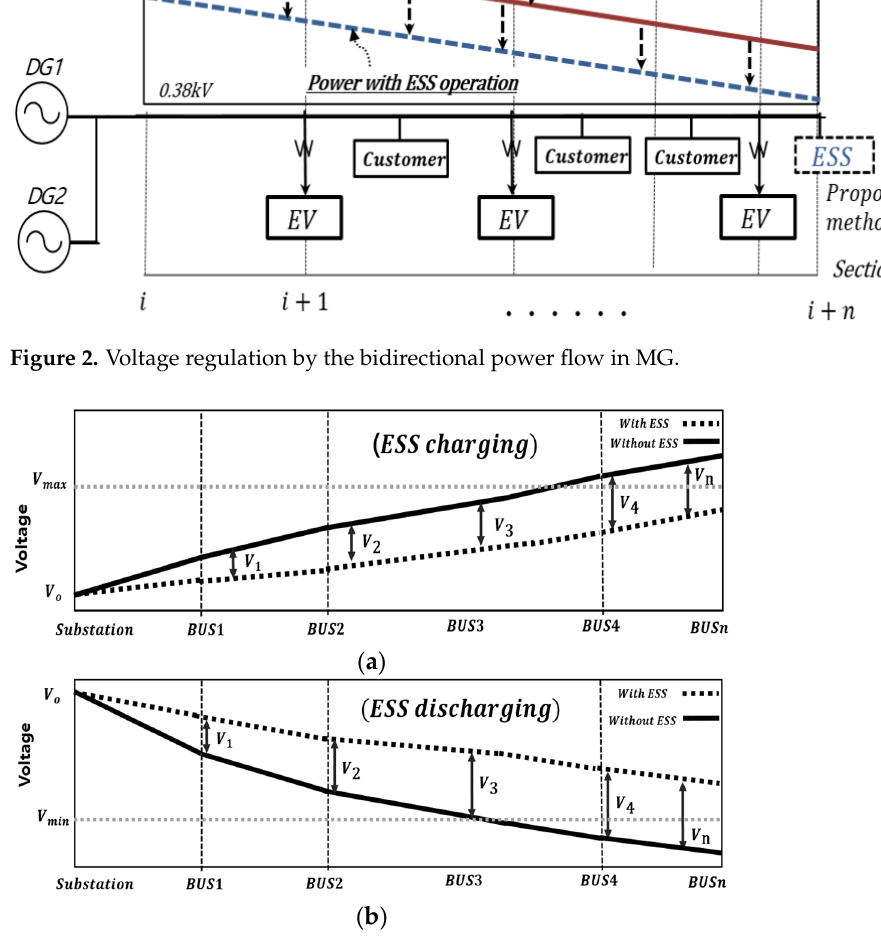
Figure 3. Bus voltage according to ESS charging/discharging. ( a ) Bus voltage characteristics during ESS charging and ( b ) Bus voltage characteristics during ESS discharging.